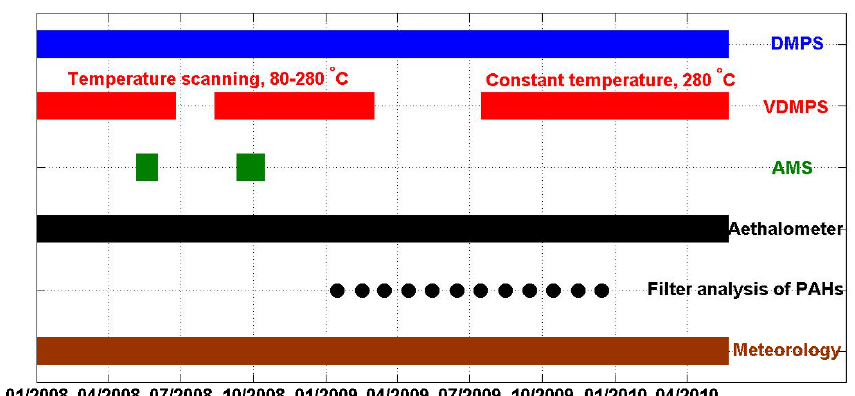
Fig. 1. Instruments used in this study and their functioning times from January 2008 to May